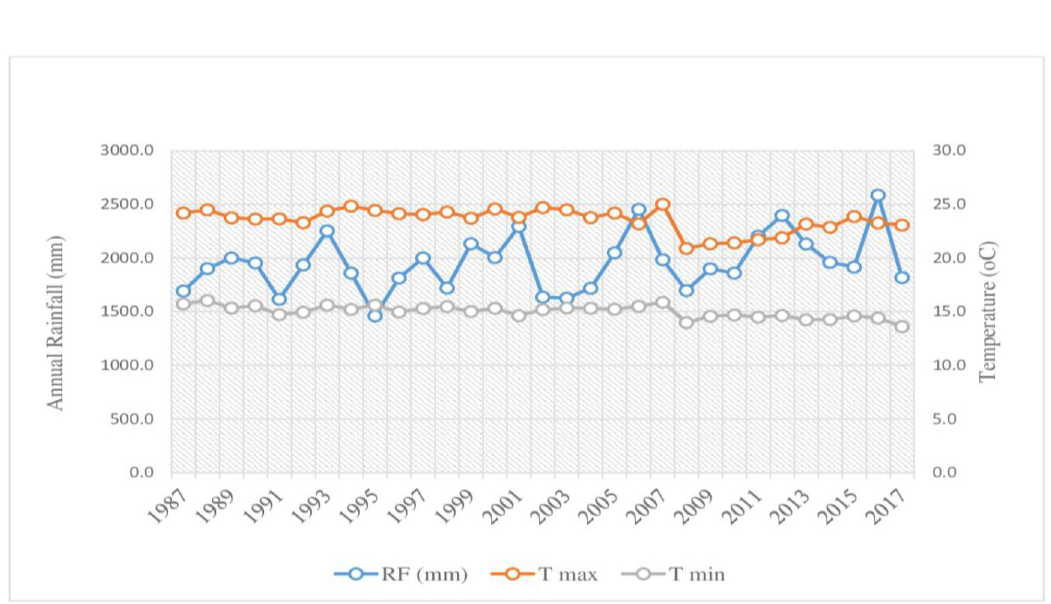
Fig 2. Mean annual RF, max and min temperature of Somodo watershed. Land-use: Somodo watershed is characterized by a coffee-based farming system and agroforestry practices. Land-use of the watershed described as cultivation land (land covered by annual crop), Forest land (natural and plantation), grazing land, and agroforestry (home garden) are the major land-uses. The dominant land-uses are agroforestry practice (46.97%), cultivation land (21.26%), forest land (18.51%), and grazing land (13.26%), respectively [16].